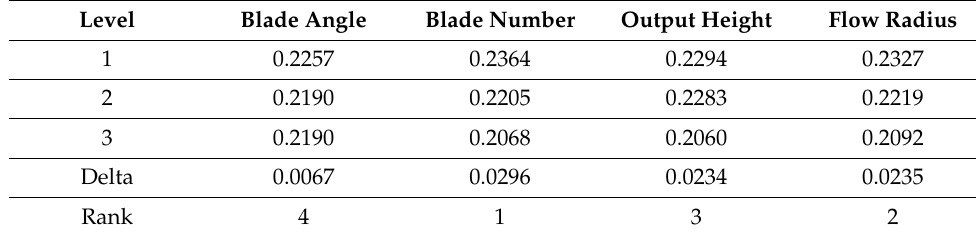
Table 7. Upper flow rate analysis of means.